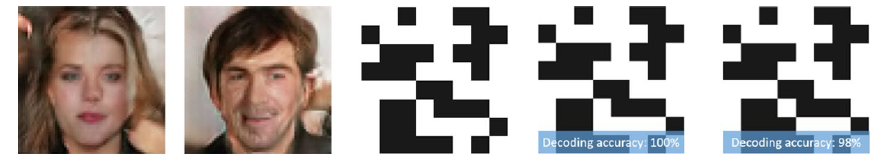
Fig. 6 A visual example of the recovery ability of